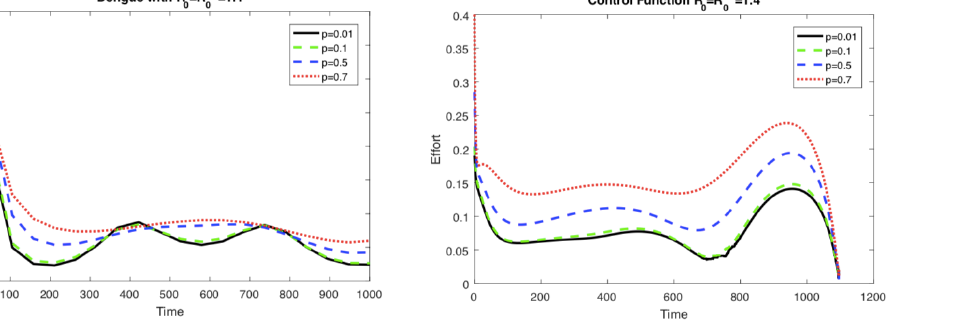
( a ) Proportion of the total population infected with ( b ) The effort is the percentage of all infections either strain DENV-2 American or DENV-2 Asian when prevented when the dominant strain is DENV-2 Asian, β Am = 0.154 and β As = 0.3 − 0.15. the dominant strain is DENV-2 Asian, β Am = 0.154 and β As = 0.3 − 0.15. Figure 6. When the dominant strain is DENV-2 Asian, as the level of vertical transmission increases, the level of optimal control increases ( b ). However, it is harder to control the outbreak ( a